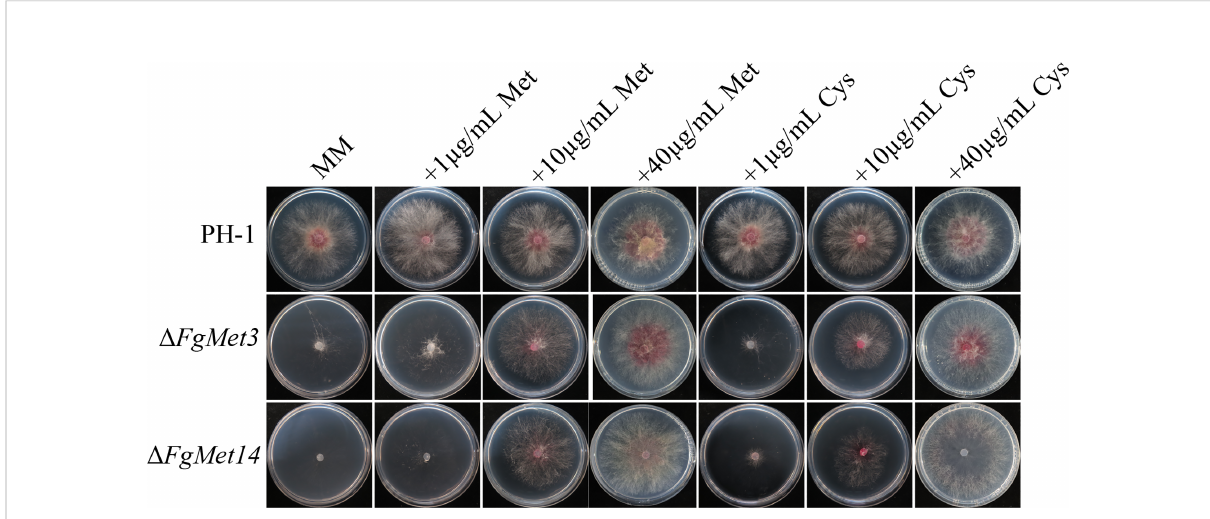
FIGURE 3 Colony diameter and morphology of PH-1, D FgMet3 and D FgMet14 mutants and their complements cultured on MM medium supplemented with different concentrations (1 m g/mL, 10 m g/mL and 40 m g/mL) of cysteine and methionine. The strains were cultured on the medium at 25°C for 3